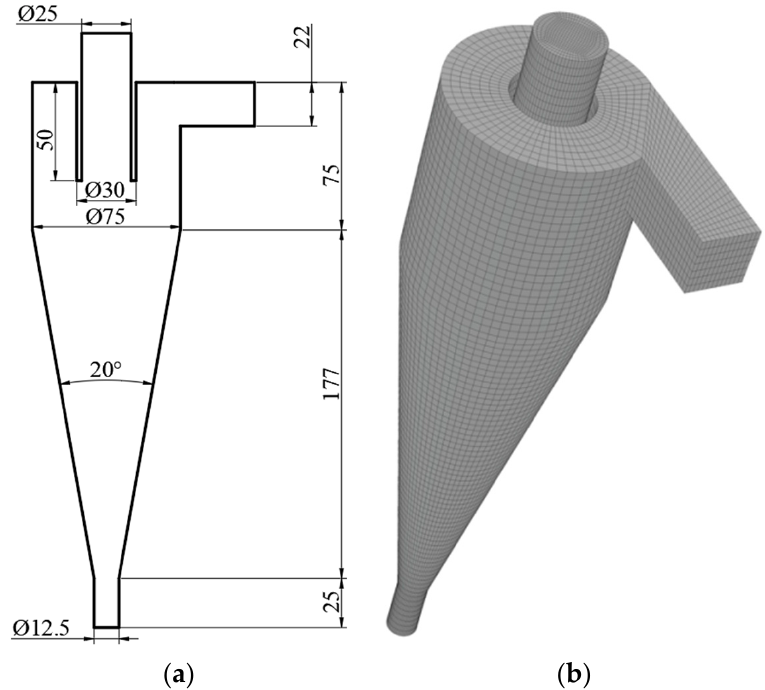
Figure 1. Hydrocyclone. ( a ) Schematic of hydrocyclone; ( b ) Meshing of hydrocyclone.